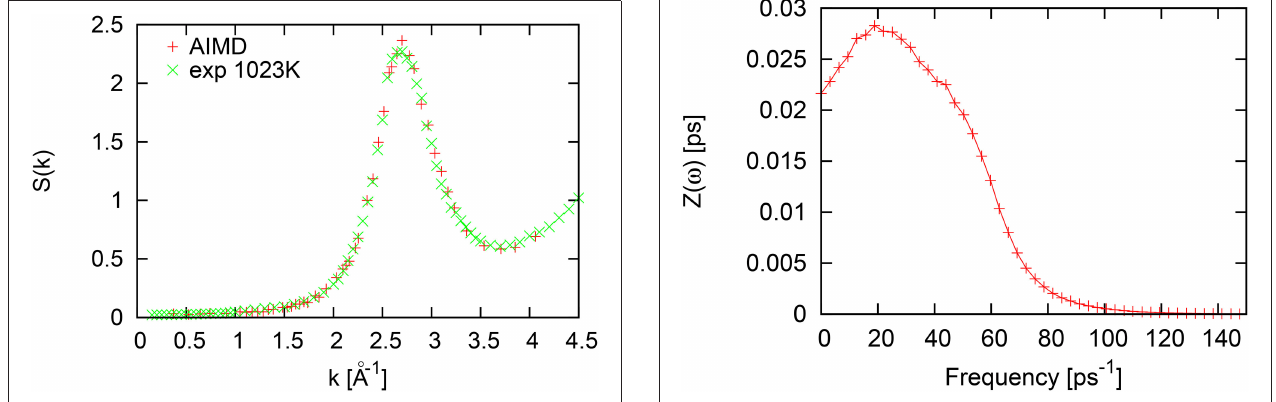
FIGURE 1 | Structure factor of liquid Al at 1000 K. FIGURE 2 | Fourier spectrum of velocity autocorrelation function for liquid